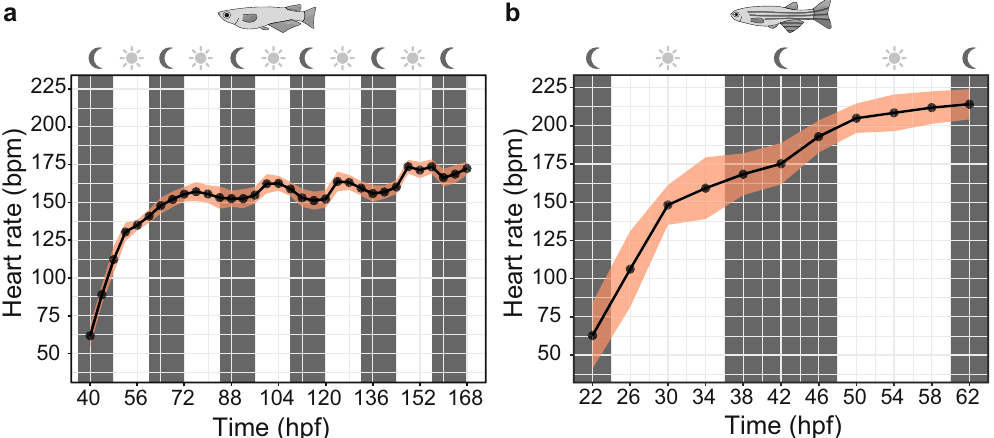
Figure 4. Heart rates of medaka and zebrafish during embryonic development. ( a , b ) Heart rates of unhatched embryos were measured from onset of heartbeat until hatching (details in Methods). ( a ) Circadian oscillation of heart rate in medaka from 3 dpf onwards (mean ± s.d., n = 13–18 each point in time). ( b ) In zebrafish, the onset of the heartbeat was followed by an immediate increase of heart rate passing into a less steep slope of increase at around 210 bpm (mean ± s.d., n = 12–52 each point in time).